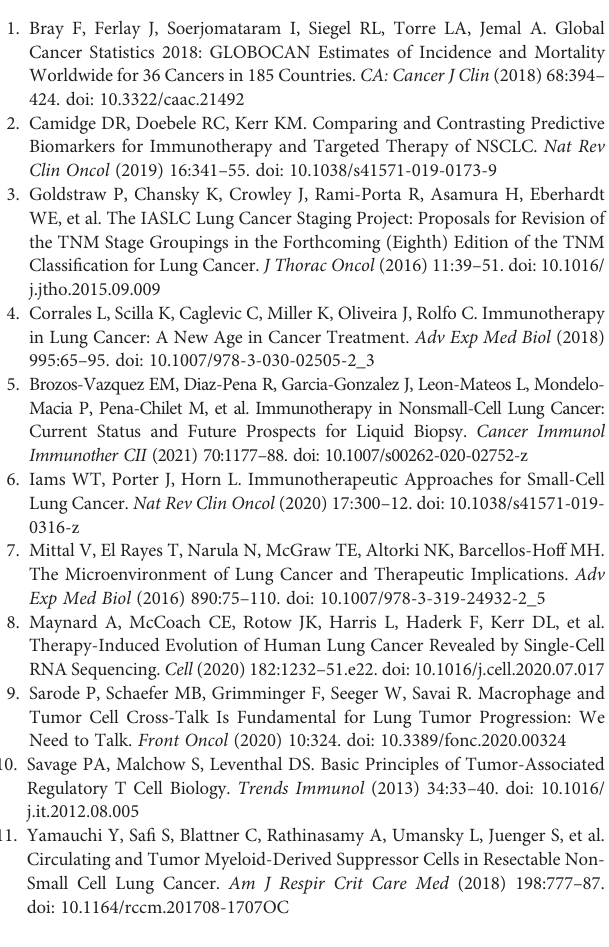
(D) Percentages of killed NALM-18 target cells by NK cells in autologous setting. One representative experiment out of 3 performed. (E) Cytokine production and degranulation capabilities of NK cells conditioned or not. Cells were analyzed after 4h of co-culture with NALM-18 target cells. Bars indicated percentage of median of cytokines production (IFN- g and TNF- a ) and degranulation (CD107a) of NK and cond. cells (n = 11). *p ≤ 0.05; **p ≤ 0.005; ***p ≤ 0.0005; ns, not signi fi cant.